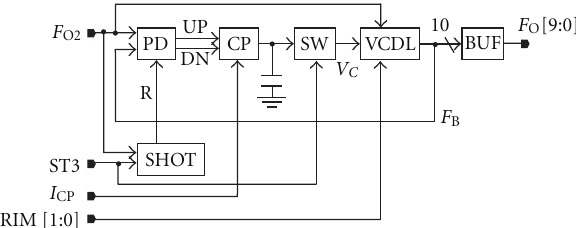
Figure 6: Block diagram of DLL. F O2 and F O [9:0] are 480MHz and 10-tap 480 MHz, respectively. The capacitor is 1pF.